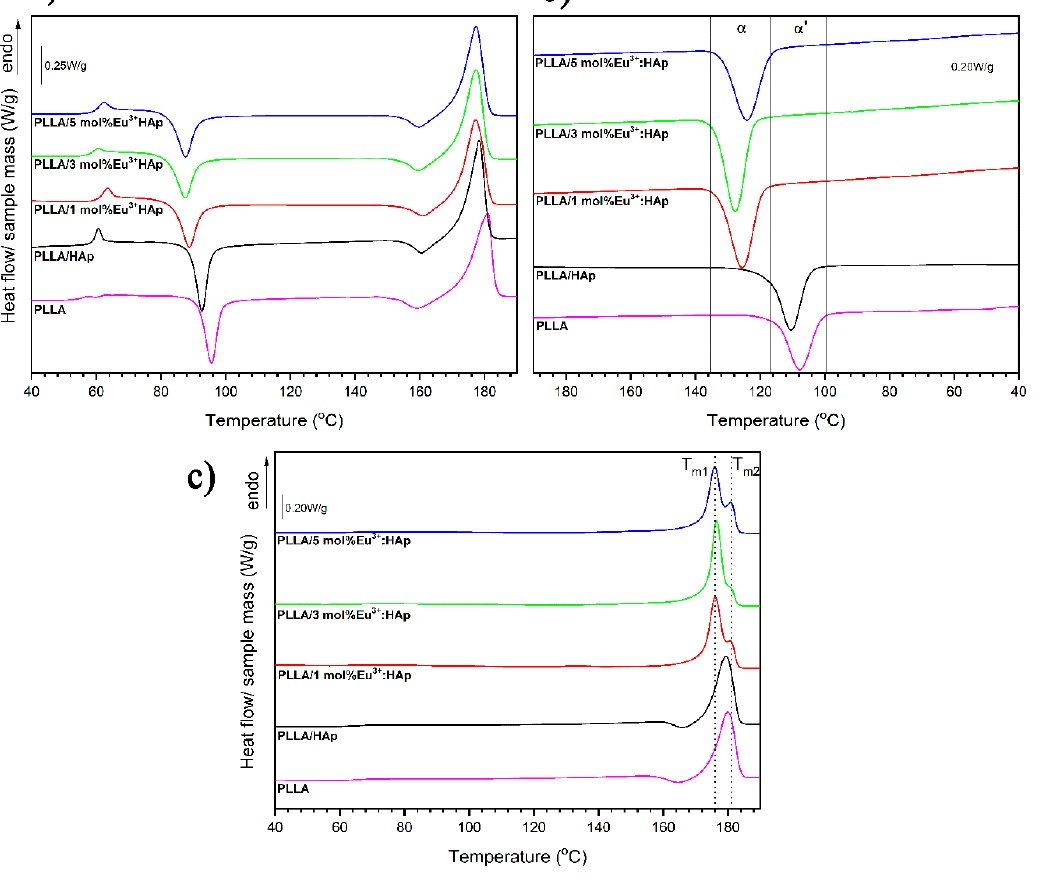
Figure 5. The first heating ( a ), cooling ( b ) and second heating ( c ) DSC curves of PLLA and PLLA/x mol% Eu 3+ :HAp composites (where x = 0–5).